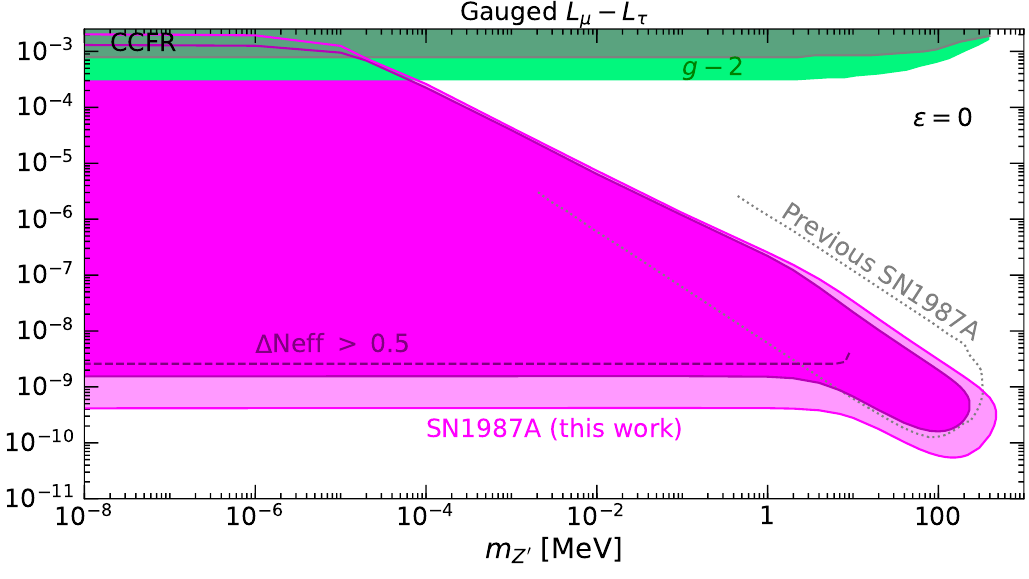
Figure 3. Parameter space for L µ − L τ gauge bosons, where there is no kinetic mixing present. This plot is also applicable to a muon-only coupled Z 0 , though in that case the bounds are weaker √ by a factor of 2 above masses of about 10 MeV (there are also different complementary constraints for that case, see text). New SN1987A limit is shown as magenta shaded region. Inner region is conservative calculation, outer is less